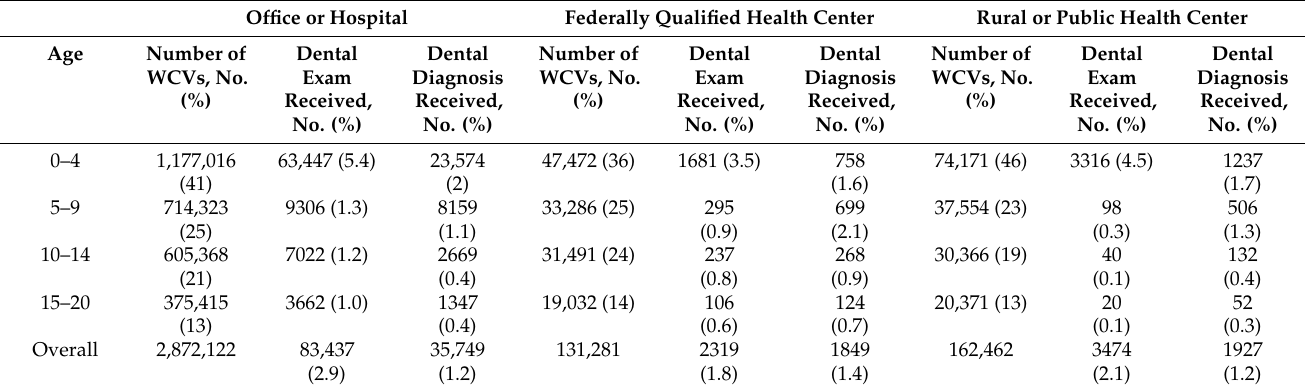
Table 1. Children who received a dental exam and dental diagnosis at the Well-Child Visit (WCV) by age and location. Office or Hospital Federally Qualified Health Center Rural or Public Health Center Age Number of WCVs,